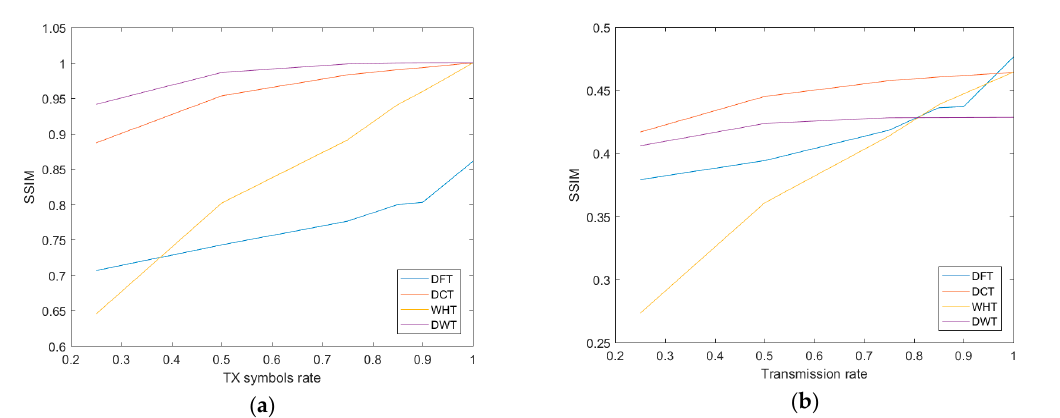
Figure 1. The relationship between compression rate and image quality (SSIM) is shown for two levels of signal-noise rate (SNR): ( a ) 100 dB additive white Gaussian noise (AWGN); ( b ) 15 dB